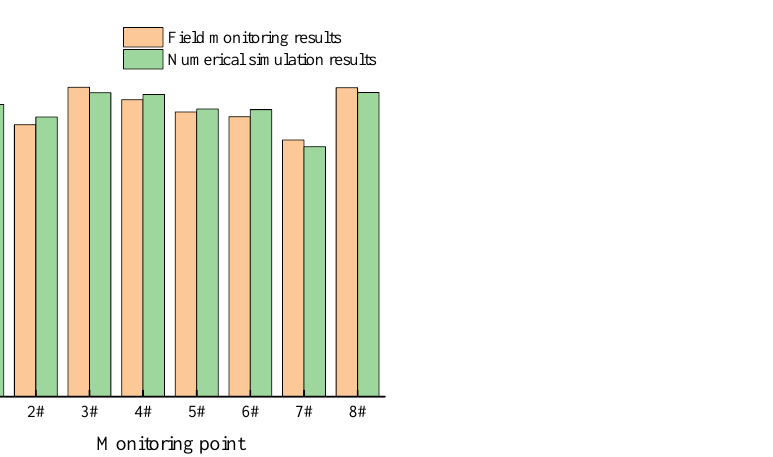
Figure 17. Surrounding rock deformation curve. ( a ) 1#; ( b ) 2#; ( c ) 3#; ( d ) 4#; ( e ) 5#; ( f ) 6#; ( g ) 7#; and